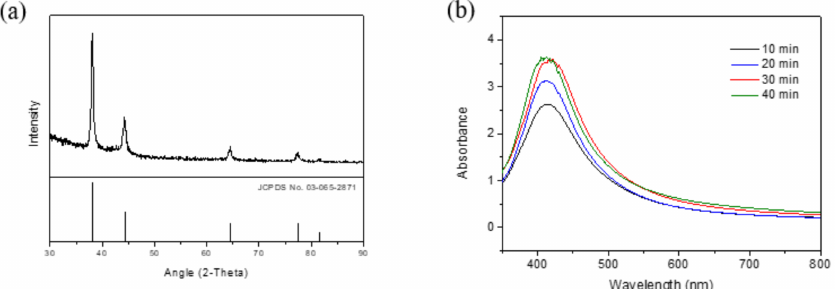
Figure 2. ( a ) The X-ray diffraction (XRD) spectra of the prepared nanoparticles; and ( b ) UV-Vis maps obtained for samples prepared using various reaction